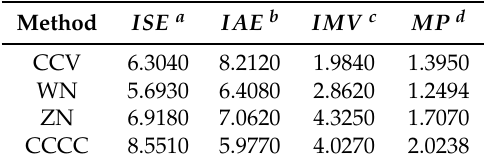
Table A4. Performance indexes. Disturbance rejection for the set P 2